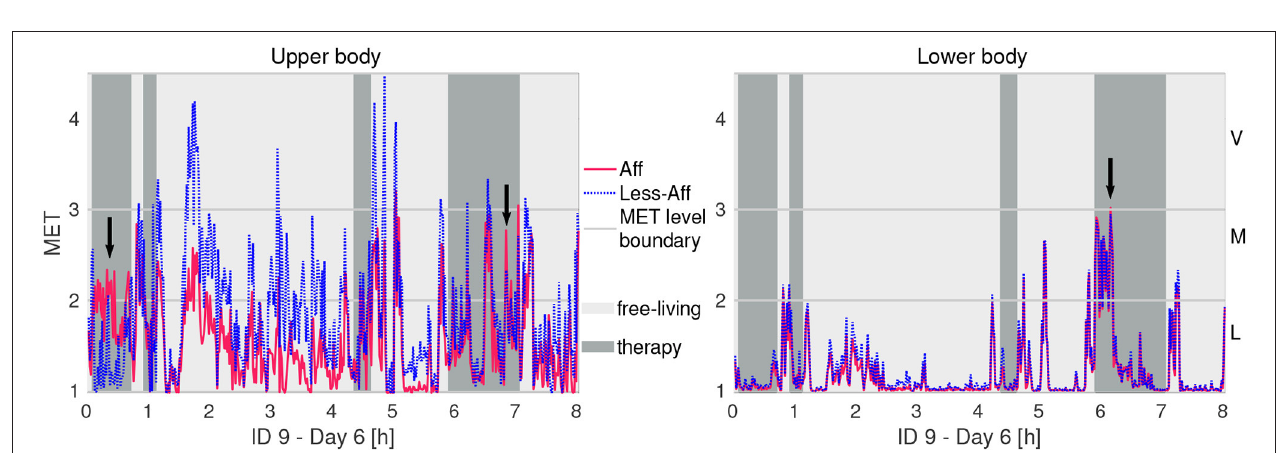
FIGURE 3 | Motion data distribution during the complete rehabilitation period for all patients (ID1 to ID11). Settings: free-living (when patients performed everyday activities), therapy (when patients attended clinician guided therapies), and other activities. Other activities were excluded from the analysis, covering times for irregular training, e.g., vibration sessions, fitness training in the gym, as well as times where the sensors had been detached.